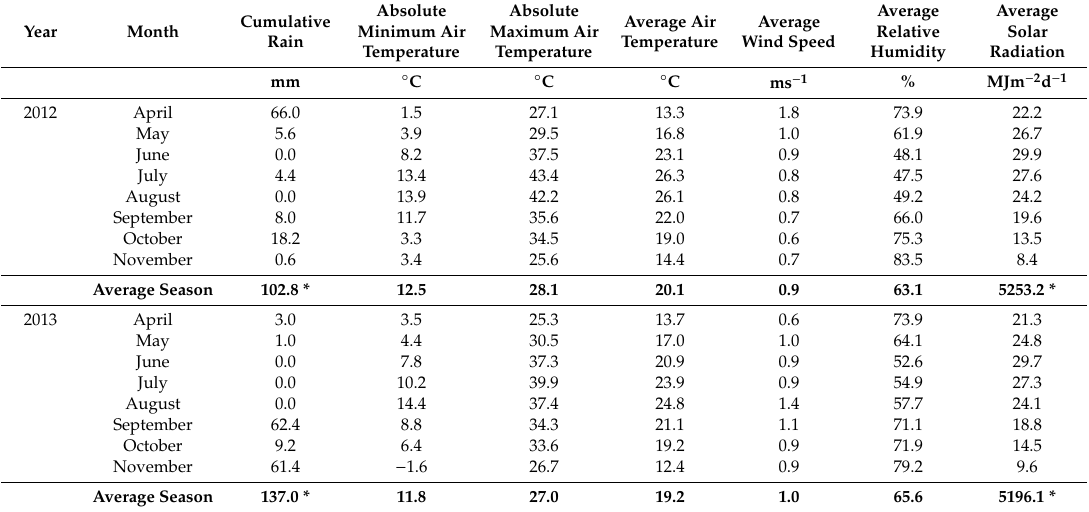
Table 2. Monthly meteorological data for the calculation of evapotranspiration (ET 0 ) in the two years.